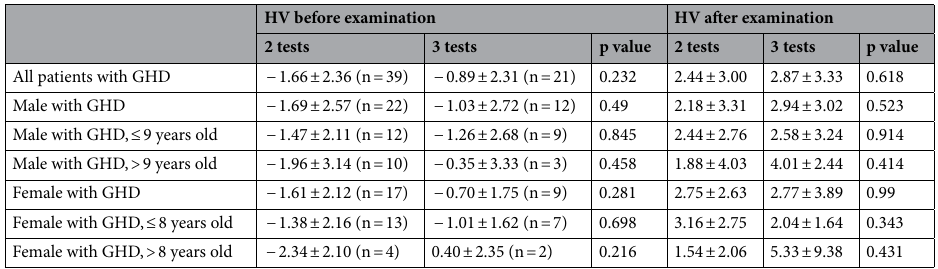
HV before examination HV after examination 2